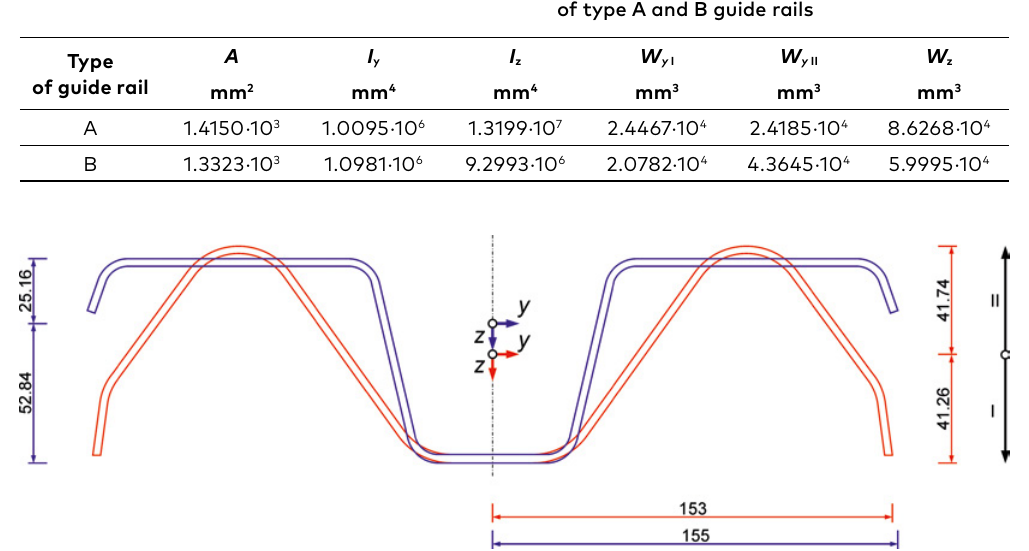
Table 1. Geometric characteristics of a cross-section